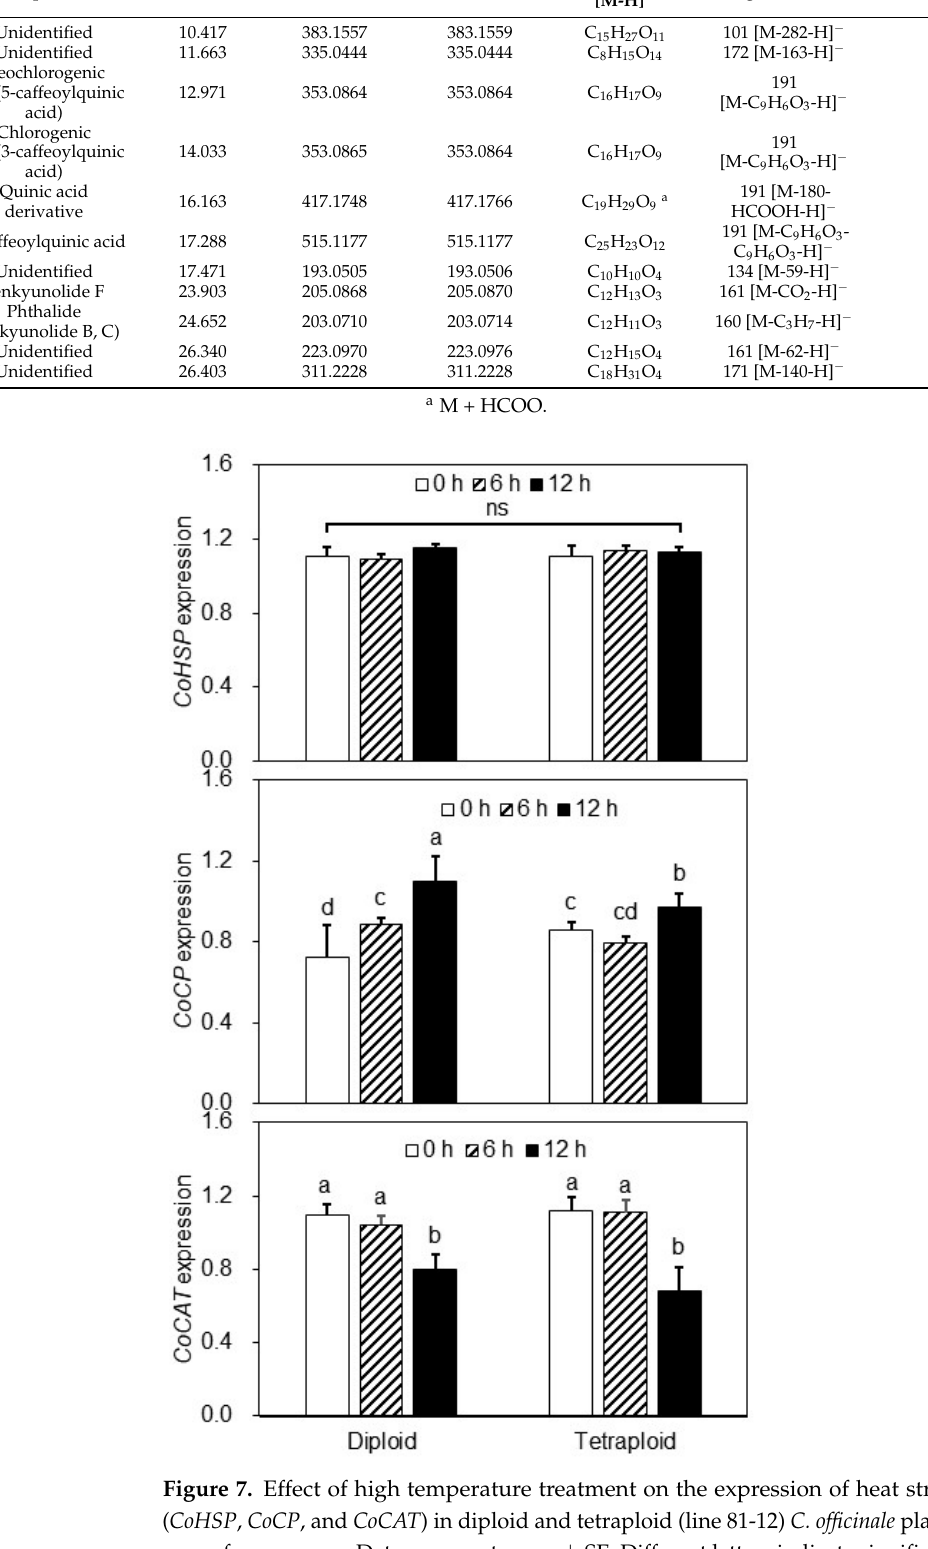
Table 4. LC–MS profiles of individual compounds detected in the methanol extract of di- and tetraploid in C. officinale . Peak No.